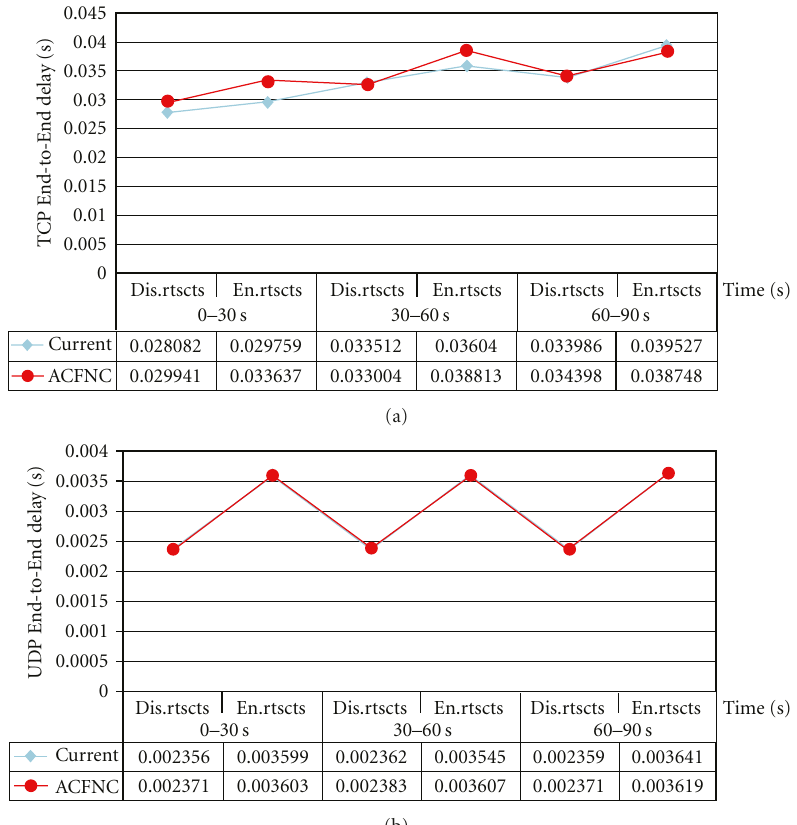
Figure 9: (a) TCP, (b) UDP delay comparison in baseline